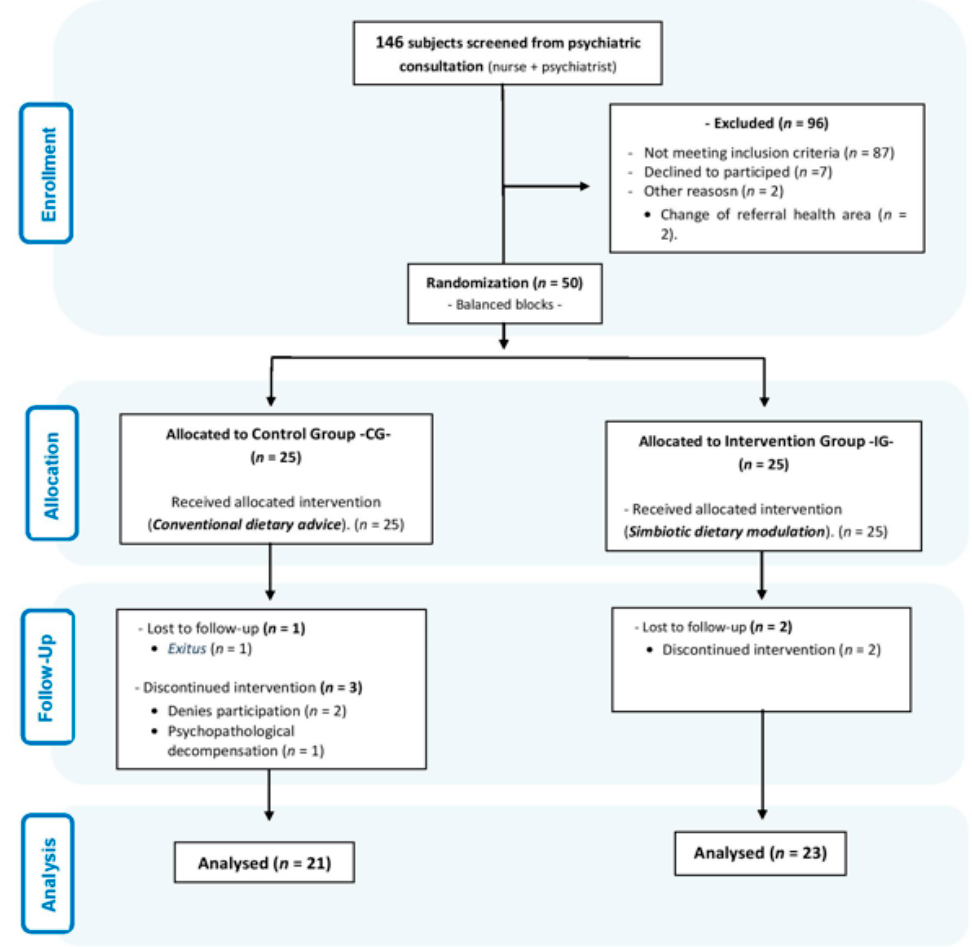
Figure 2. CONSORT flow diagram .